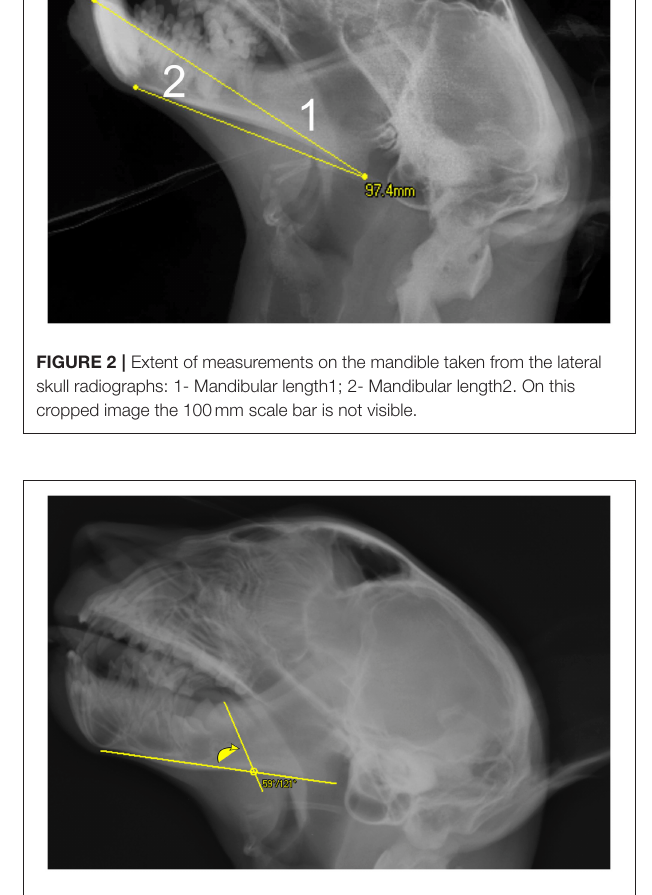
FIGURE 3 | Depiction of a line drawn through the caudal cusp and apex of the molar tooth crosses the mandibular length2 line on the lateral skull radiograph of a cheetah cub. The inside angle where these two lines cross was measured. On this cropped image the 100mm scale bar is not